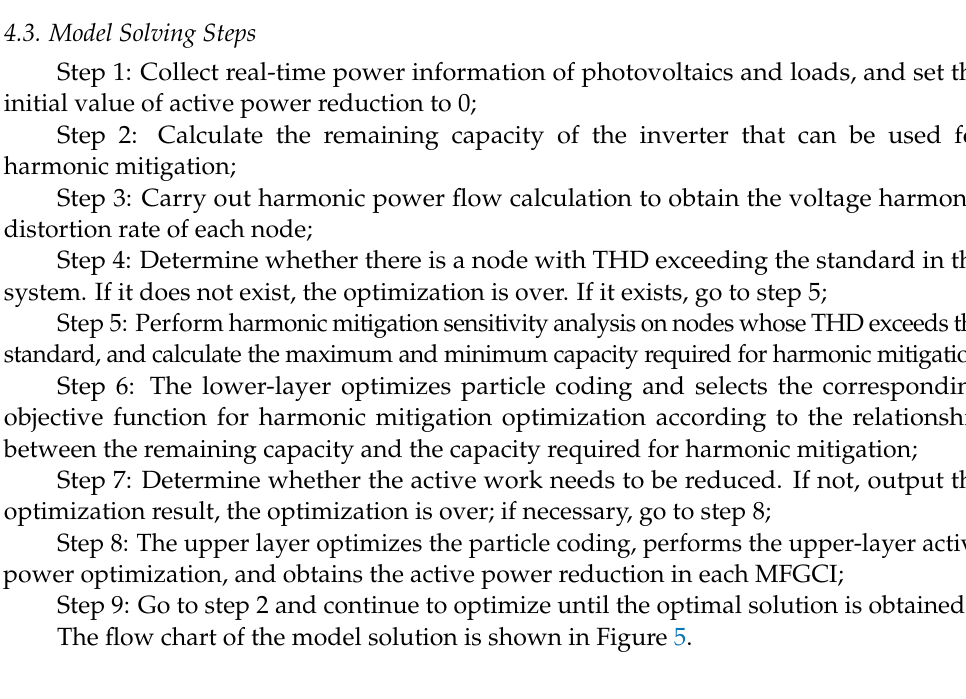
Figure 4. Lower-layer particle structure.